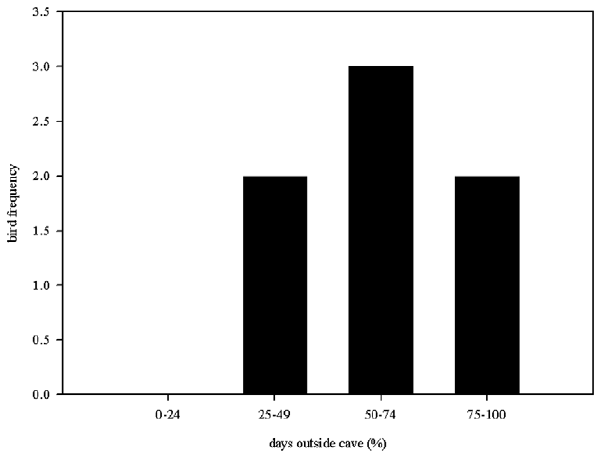
Figure 3. Percentage of nights spent roosting outside the Cueva del Gua´charo during the period of data collection.